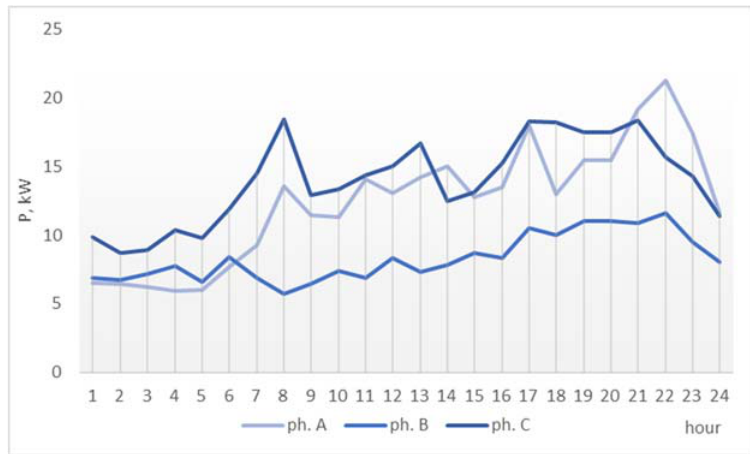
Figure 6. Demand in network R28.